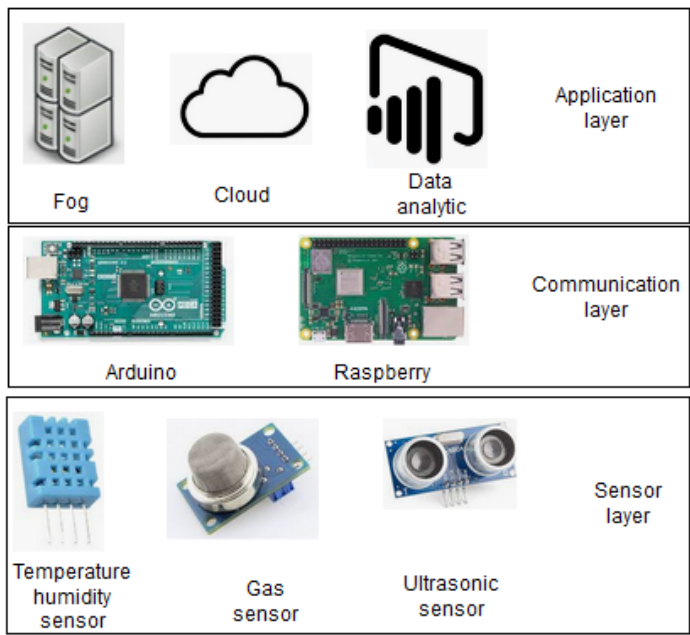
Figure 13. IoT application based on Raspberry and Arduino.